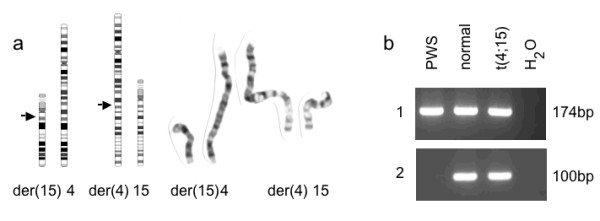
a. High resolution G-banded ideograms and prometaphase chromosomes of the translocation derivatives and their normal homologs . An apparently balanced translocation t(4;15)(q27;q11) was identified with arrows indicating band location of breakpoints. b. DNA methylation analysis of CpG island of SNRPN promoter and exon 1. 1. The 174 bp PCR product is derived from the methylated maternal chromosome. 2. The 100 bp product is derived from the paternal chromosome. PWS: PWS control, Normal: normal control, and t(4;15) carrier; H2O: no template control. The t(4;15) carrier shows the normal bi-parental methylation pattern.